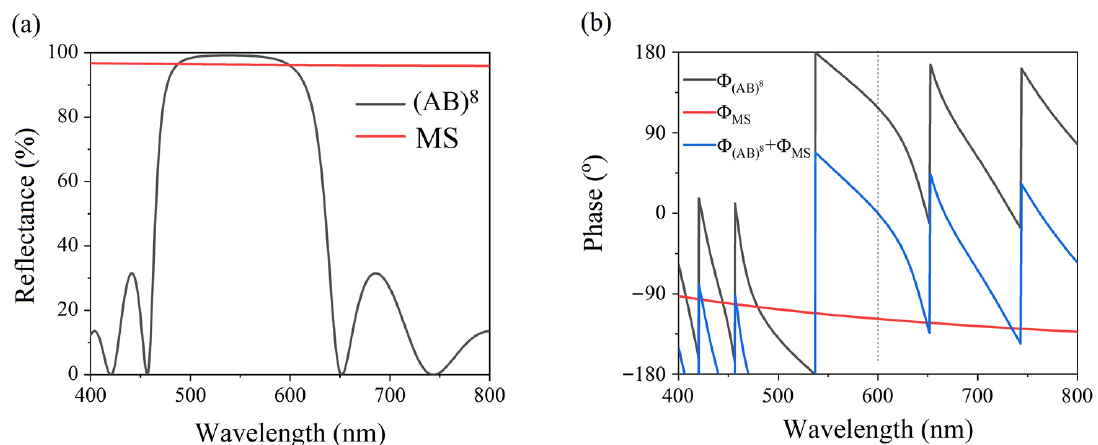
Figure 3. ( a ) Simulated reflection spectra of PC (BA) 8 (solid black line) and Ag-glass structure MS (solid red line). ( b ) Reflection phases of MS Φ MS (solid black line) and PC Φ (BA) 8 (solid red line) and the sum of Φ (BA) 8 + Φ MS (solid blue line).